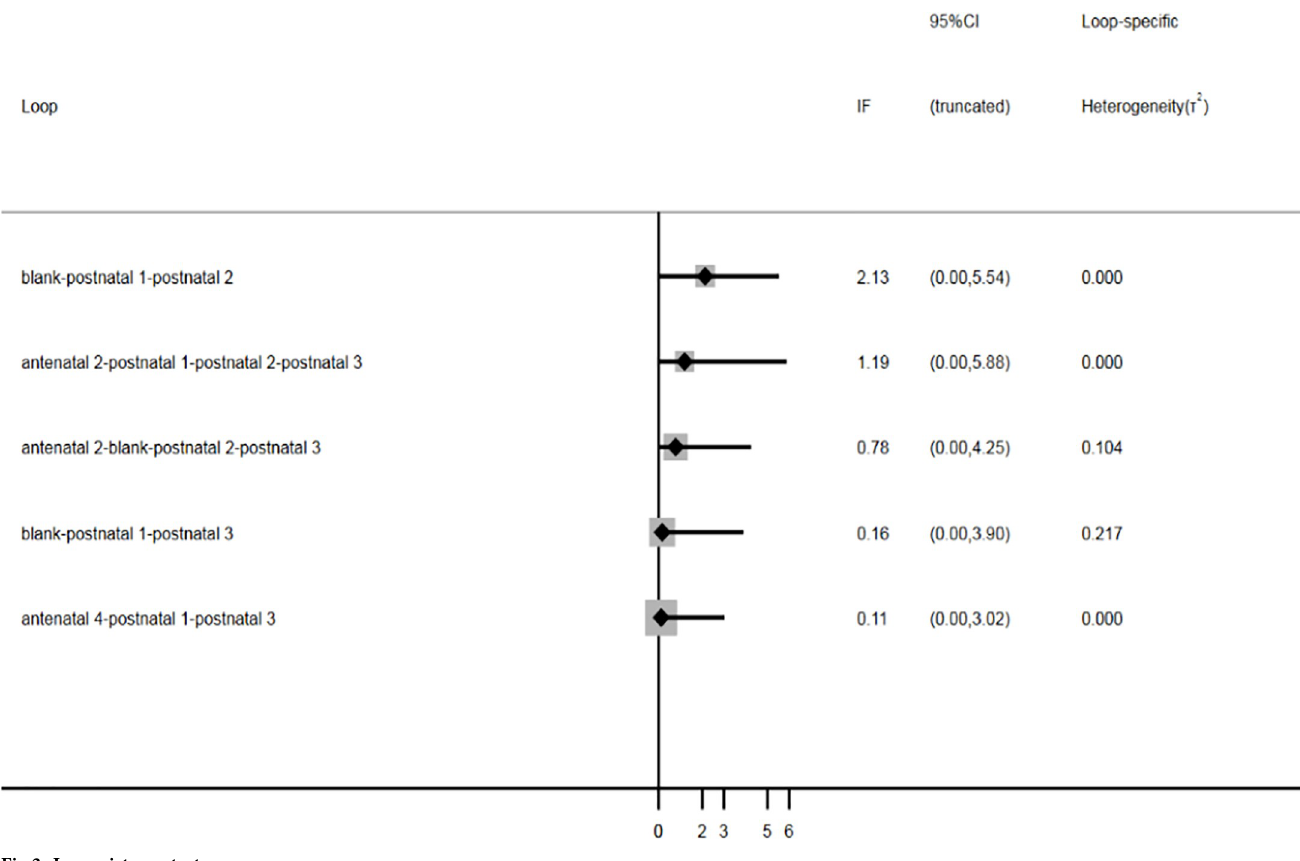
Fig 3. Inconsistency test.